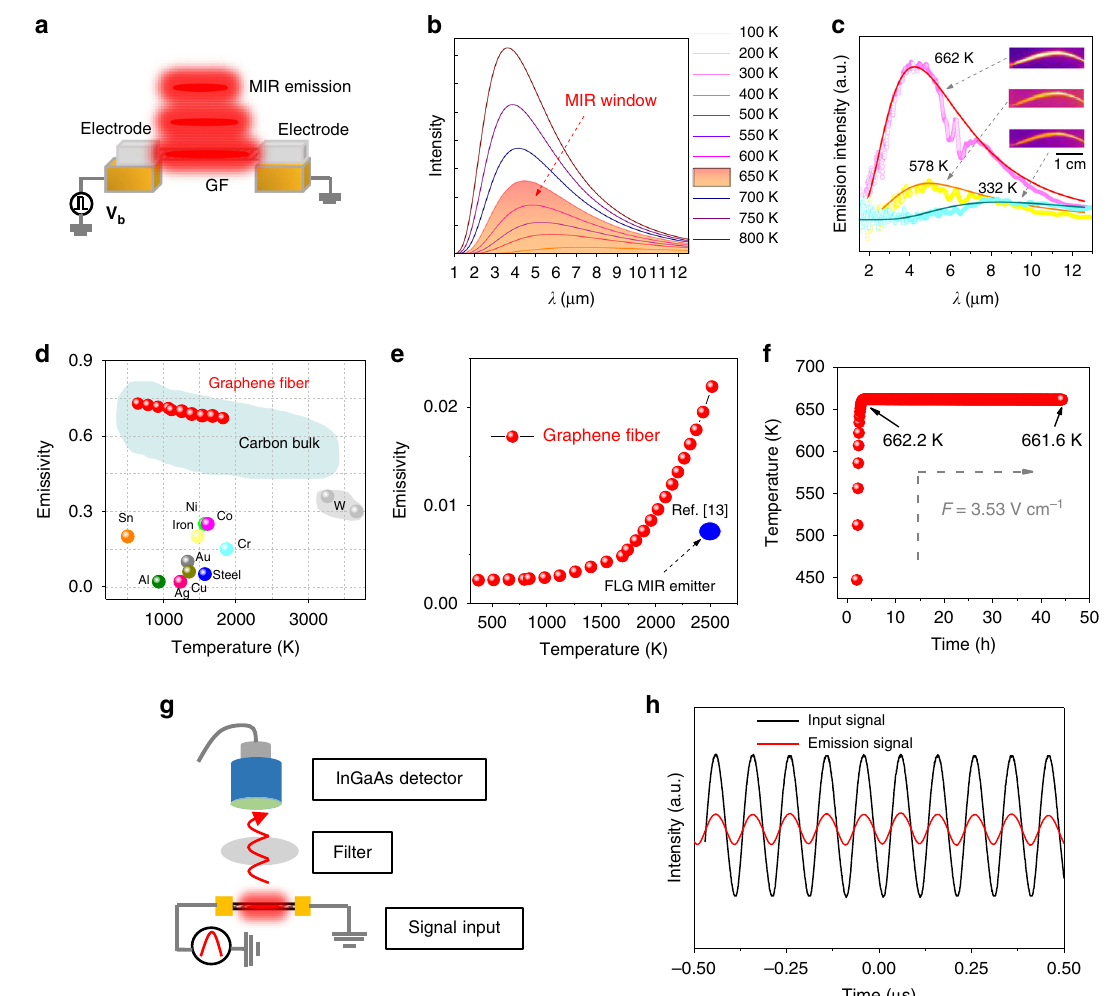
Fig. 3 GF operation in MIR emission mode. a The schematic of our device. b The theoretical MIR window of gray-body irradiance. c The IR images and emission spectra (hollow dots) of GF at 332, 578, and 662 K, which match well with the gray-body radiation simulation (solid lines). The applied electric fi elds are 1.17 V cm − 1 , 2.35 V cm − 1 , and 3.53 V cm − 1 , respectively. The emissivity ( d ) and emission ef fi ciency ( e ) of the GF emitter at different operation temperatures. f , A GF continuously emits MIR light over 40 h under a constant electric fi eld of 3.53 V cm − 1 . The schematic ( g ) and the real-time detection ( h ) of the intensity modulation of the GF emission at 10 MHz by using a commercial InGaAs detector. The V peak of input bias is 6 V, and the peak F is 3.53 V cm − 1